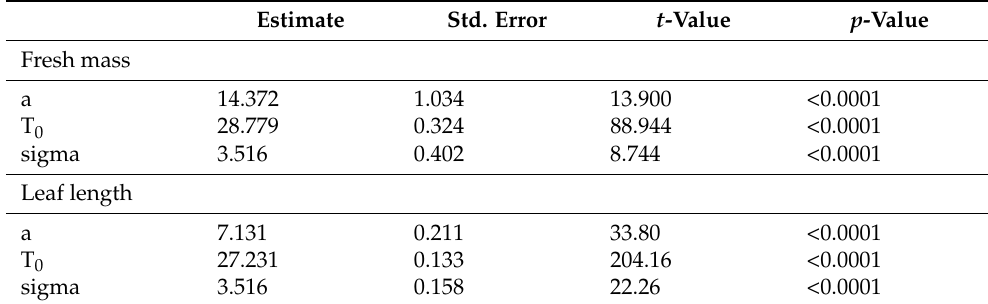
Table 2. Estimated regression parameters, standard errors, t -values, and p -values for the models explaining the effect of water temperature on fresh plant mass and leaf length of Pistia stratiotes .